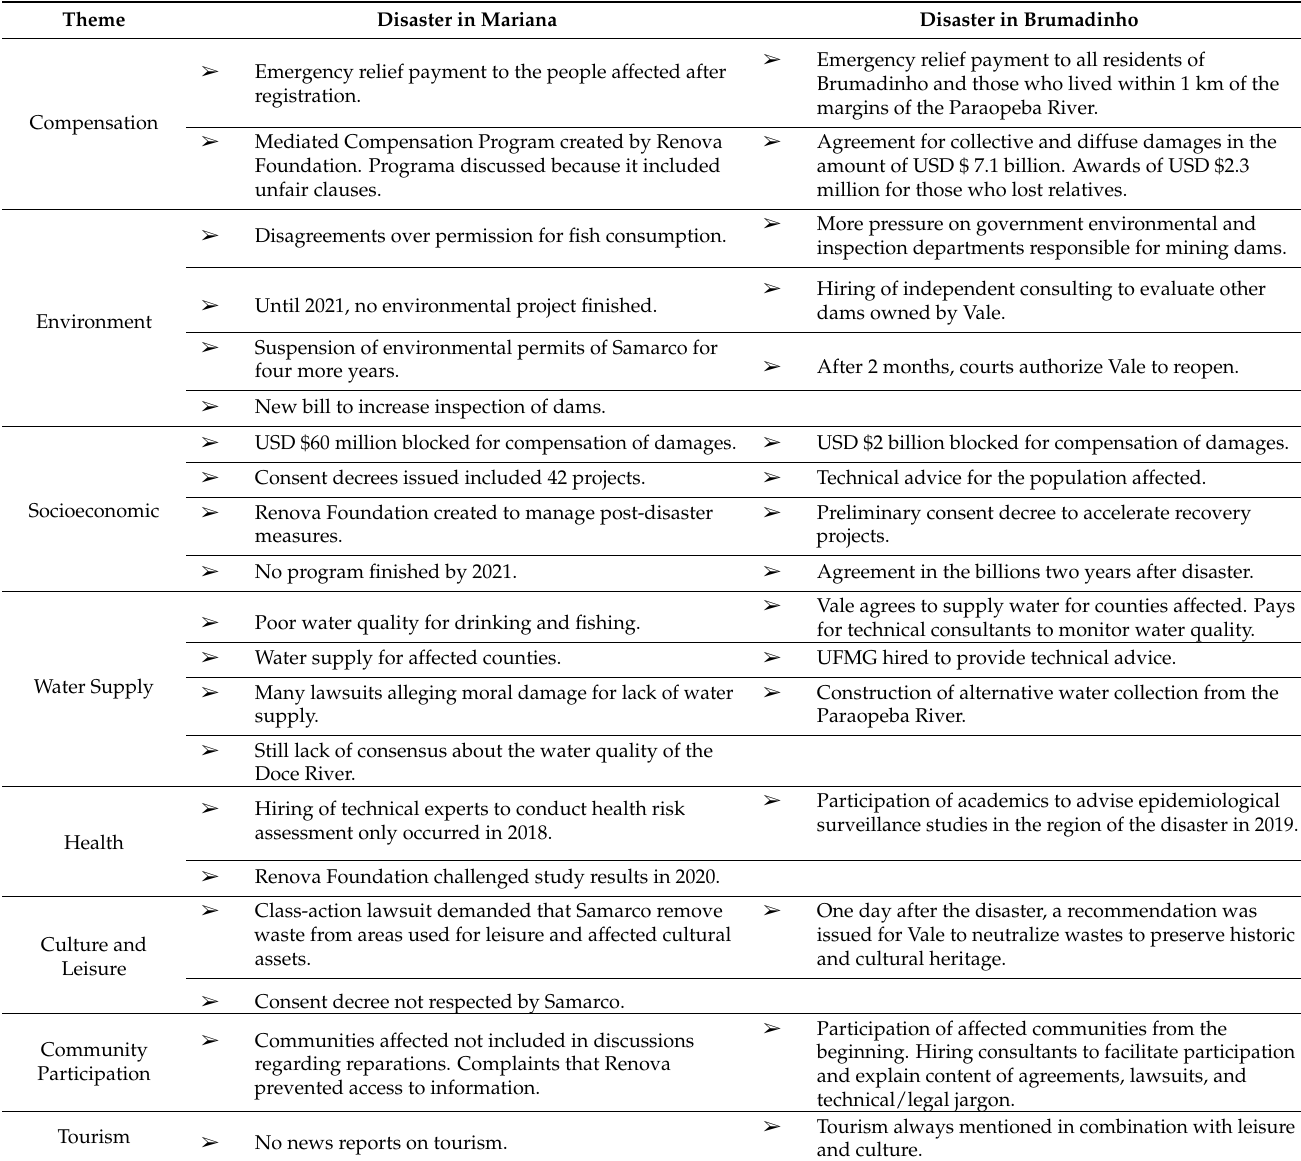
Table 2. Comparison of post-disaster themes in Mariana and Brumadinho. Disaster in Mariana Disaster in